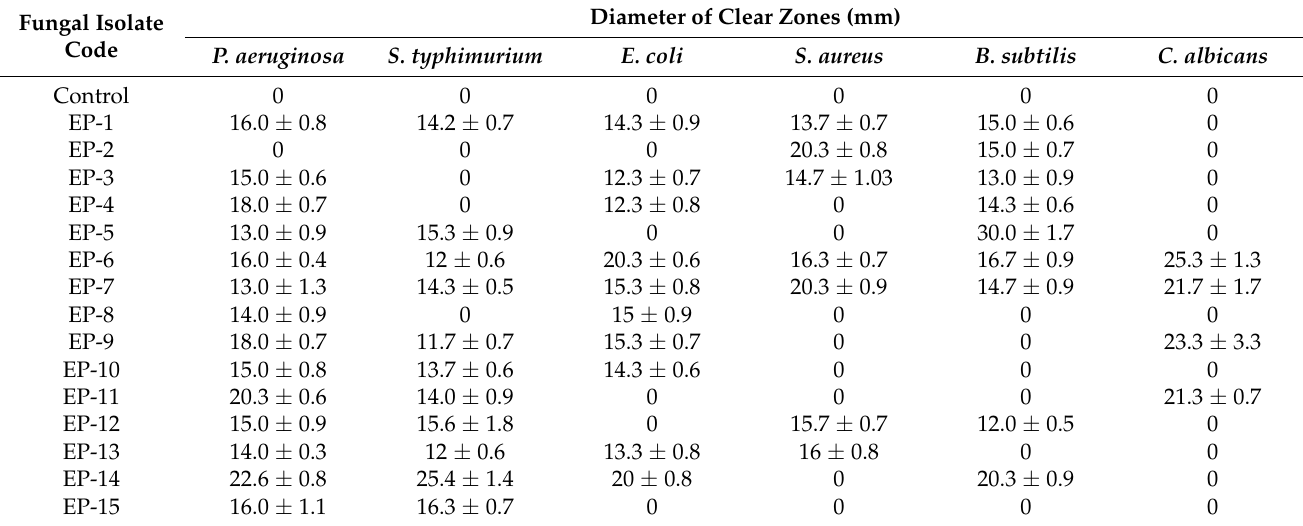
Table 3. Antimicrobial activities of fungal endophytes isolated from E.